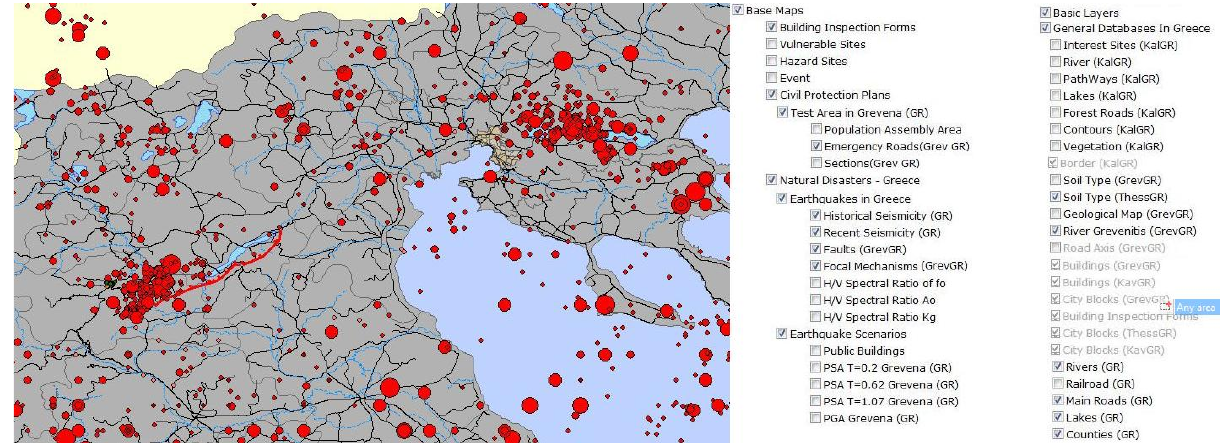
Figure 9. Land use and building assessment in Thessaloniki